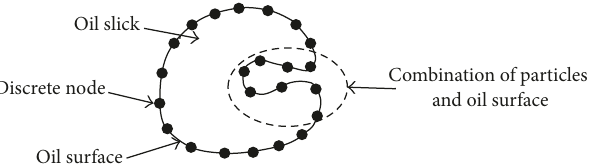
Figure 3: Description of the computing mode of the oil slick (the areasurroundedbythesolidlinerepresentstheoilslick,blackpoints represent discrete nodes along the edge of the oil slick, line between discrete nodes represents oil surface, and the area surrounded by the dashed line represents the combination of particles and oil surface).